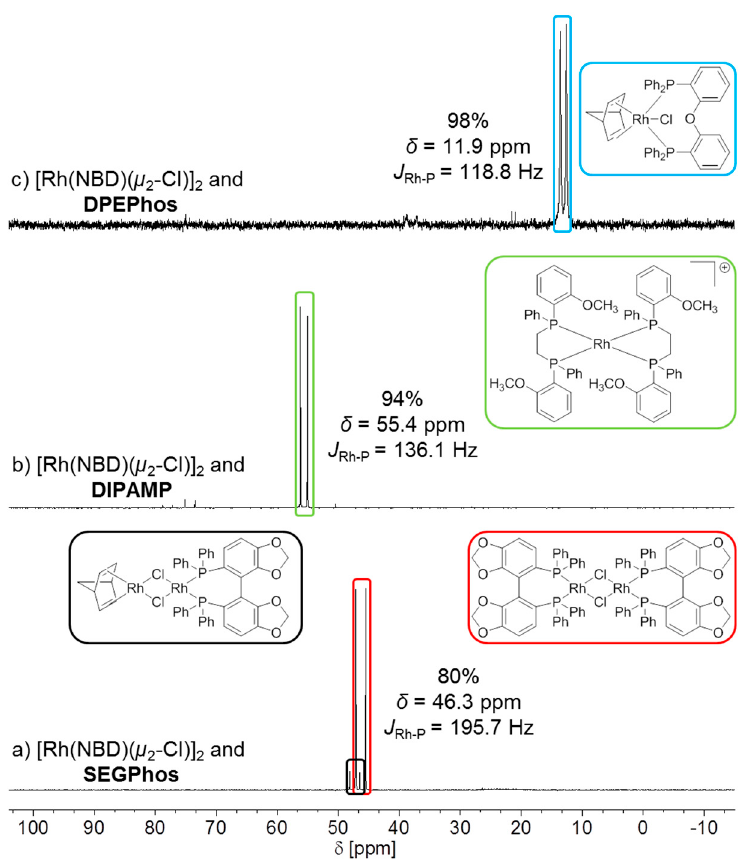
Figure 2. 31 P NMR spectra of the reaction solution for the in situ ligand exchange at room temperature in THF- d 8 between [Rh(NBD)( µ 2 -Cl)] 2 and ( a ) SEGPhos, ( b ) DIPAMP, ( c ) DPEPhos.